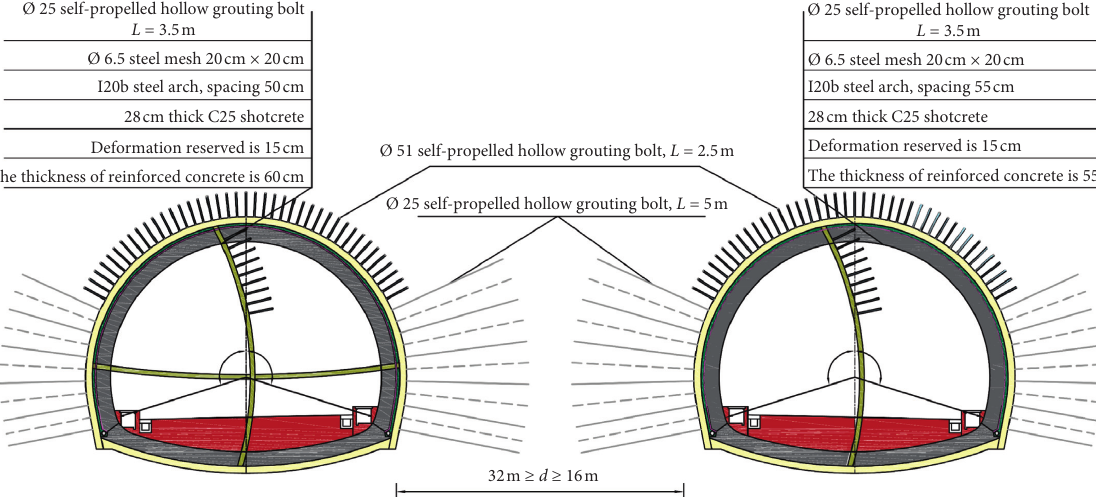
Figure 4: Tunnel section composite lining